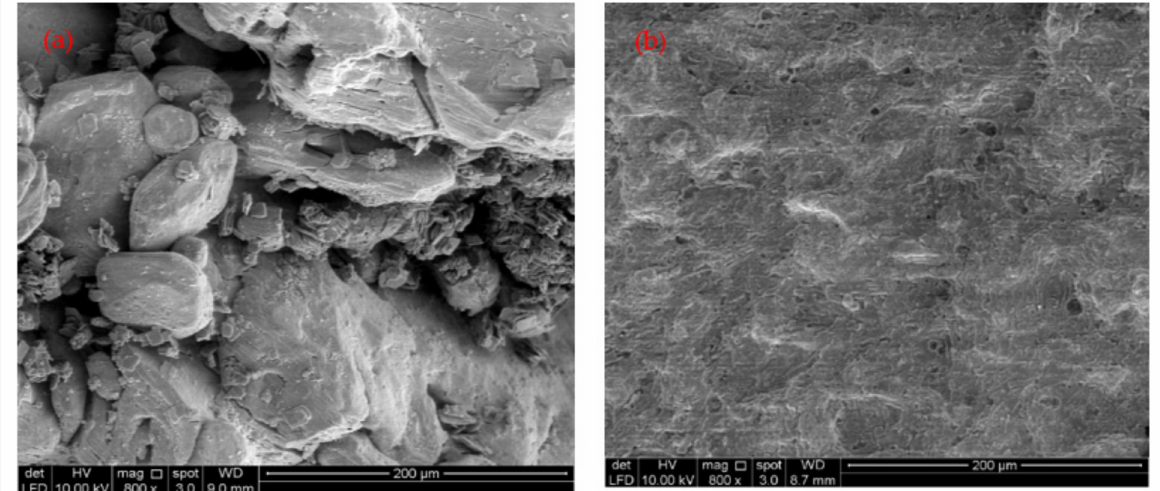
Figure 3. ( a ) SEM image of FeSO 4 · 7H 2 O waste, and ( b ) generated sludge after SPRE treatment at optimized experimen- tal conditions.